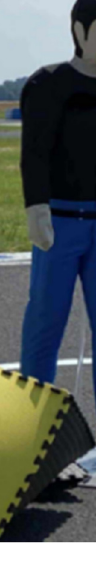
Figure 5: Pedestrian dummy. Source: “ authors ” own